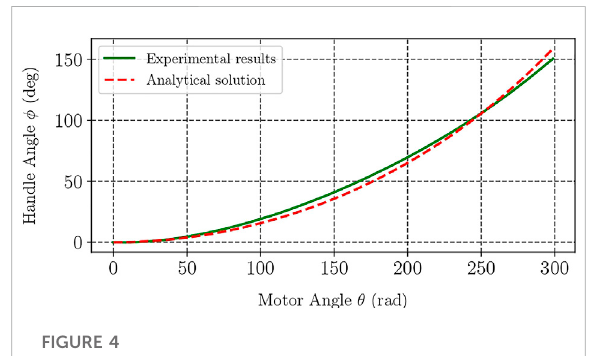
FIGURE 4 Theoretical and experimental handle angles versus the angle of twisting in the proposed haptic